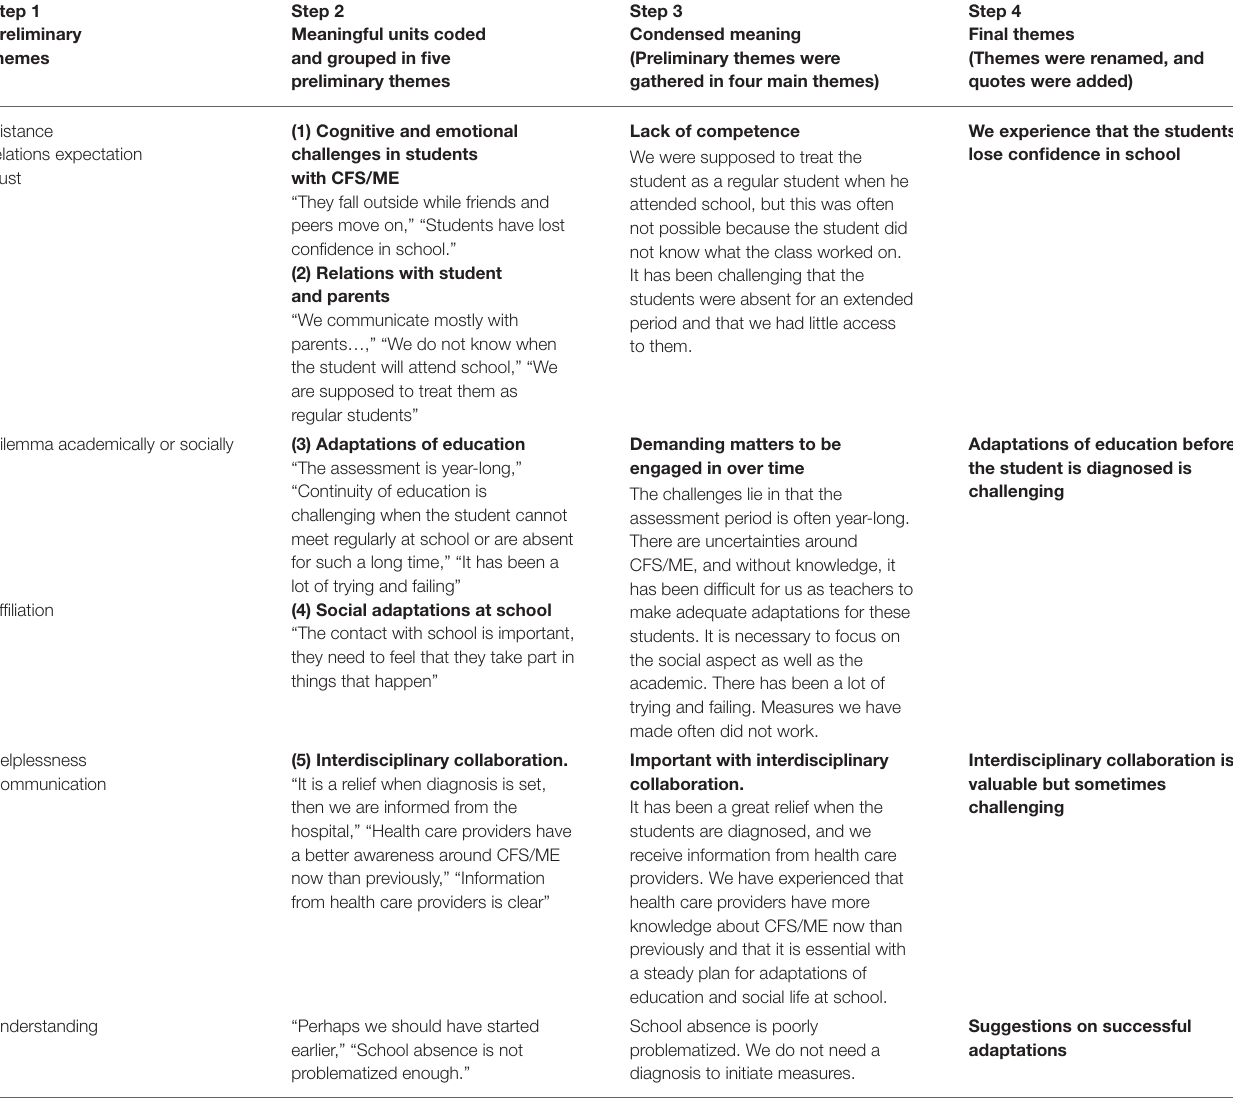
TABLE 2 | Illustration of the four steps of systematic text